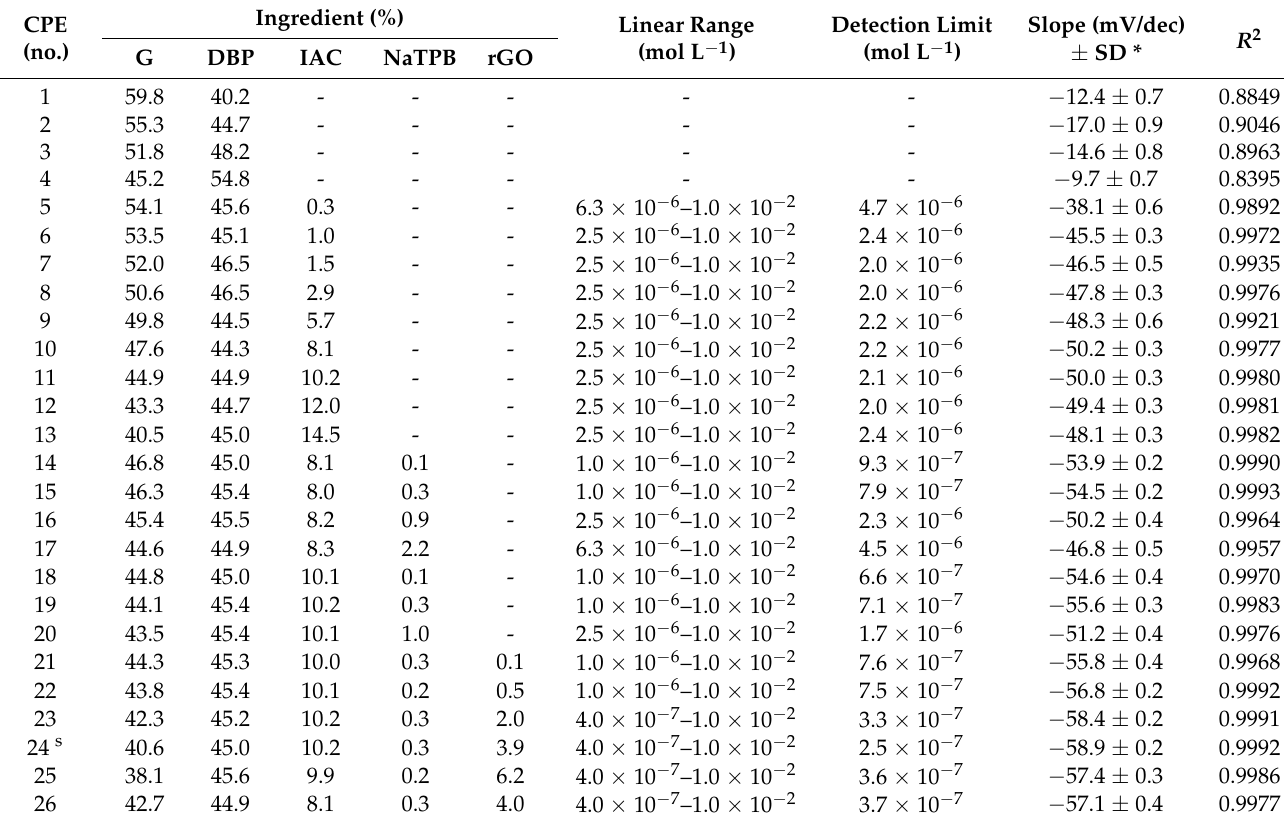
Table 1. Carbon paste composition optimization for direct potentiometric determination of THP.